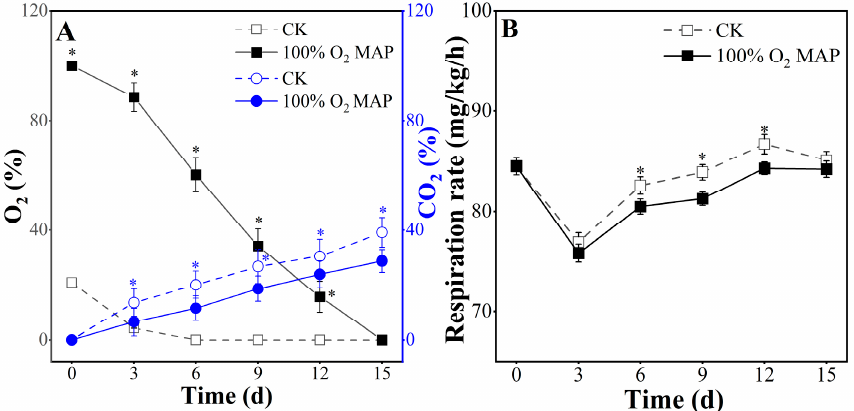
Figure 1. Effect of 100% O 2 MAP on the gas concentrations of O 2 and CO 2 ( A ) and respiration ( B ) of fresh-cut broccoli. * in the figure indicates significant differences among treatments at the same storage time ( p < 0.05). The error bar represents the standard deviation, and the data in the figure are displayed in the form of average.